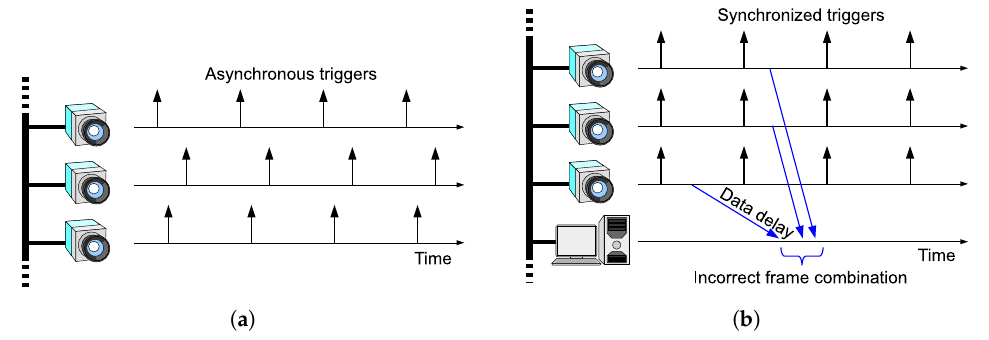
Figure 1. Synchronized HSV sensor network. Frame acquisition is synchronized among sensor nodes across the network.